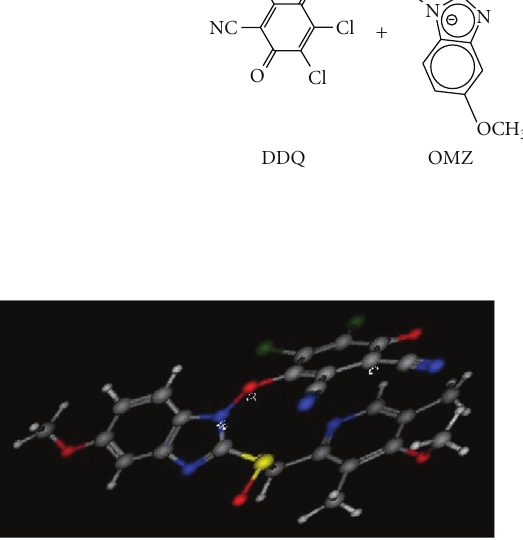
Figure 4: The most energy-minimized conformation of OMZ- DDQ charge-transfer